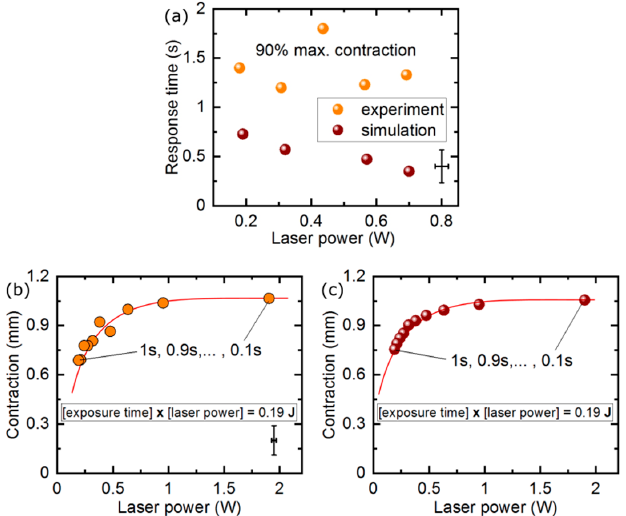
Figure 3. Linear actuator response time and stroke for different laser pulse duration. The actuator response time from zero to 90% of the maximum contraction retrieved from the measurement data in Figure 2a and simulation data in Figure 2b ( a ). Measured and simulated actuator response with the same amount of light energy delivered via laser pulses with varying duration-measurement ( b ) and simulations ( c ). The red lines are guides for an eye only.